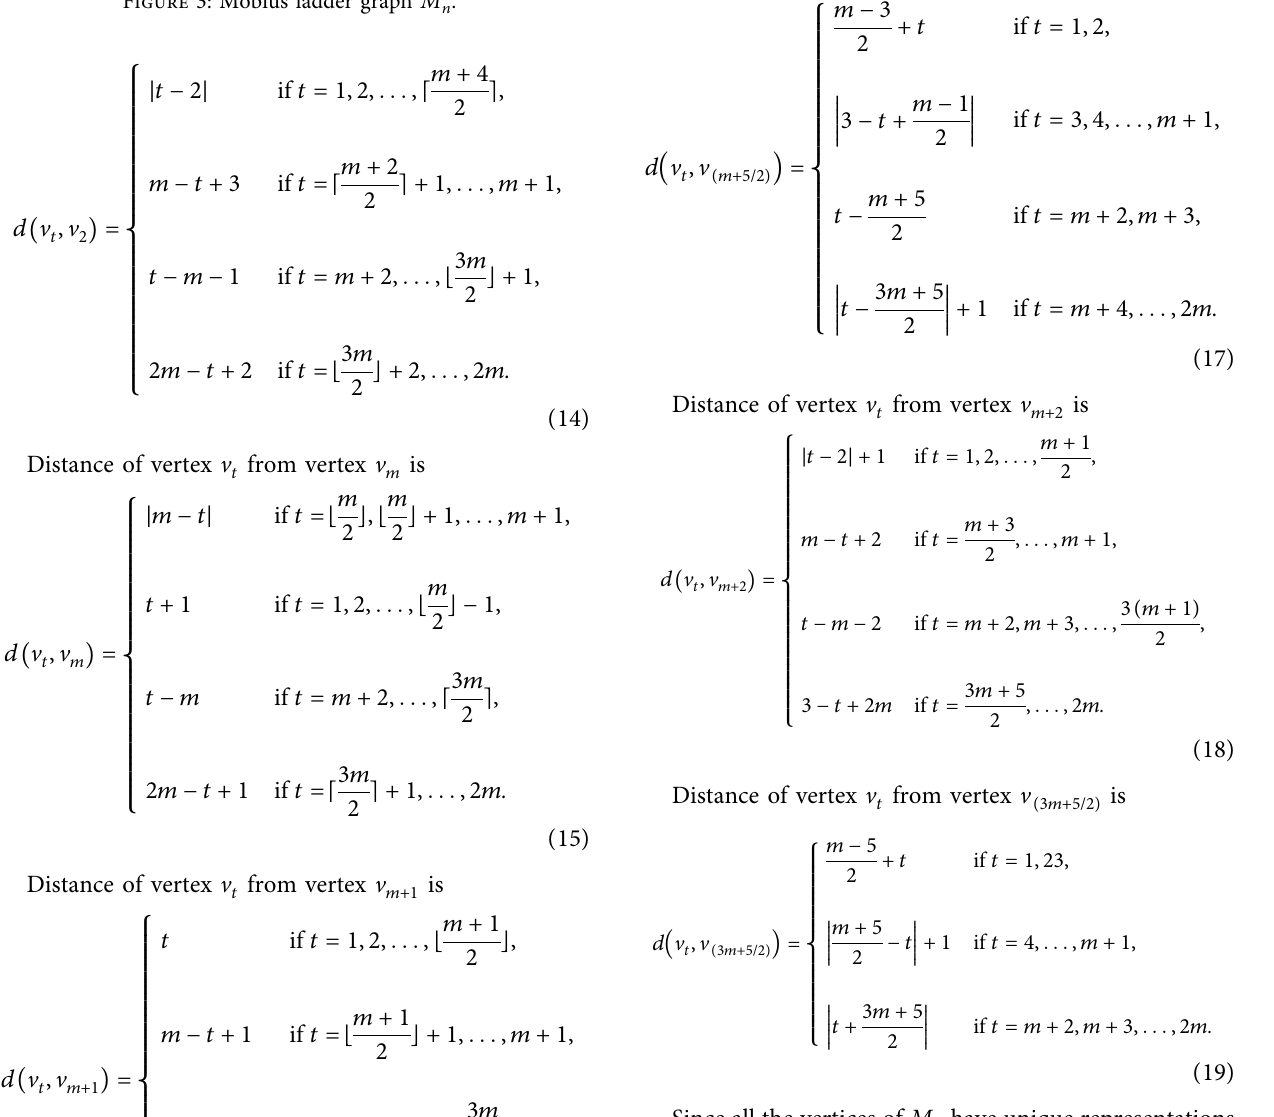
Figure 3: M¨obius ladder graph M